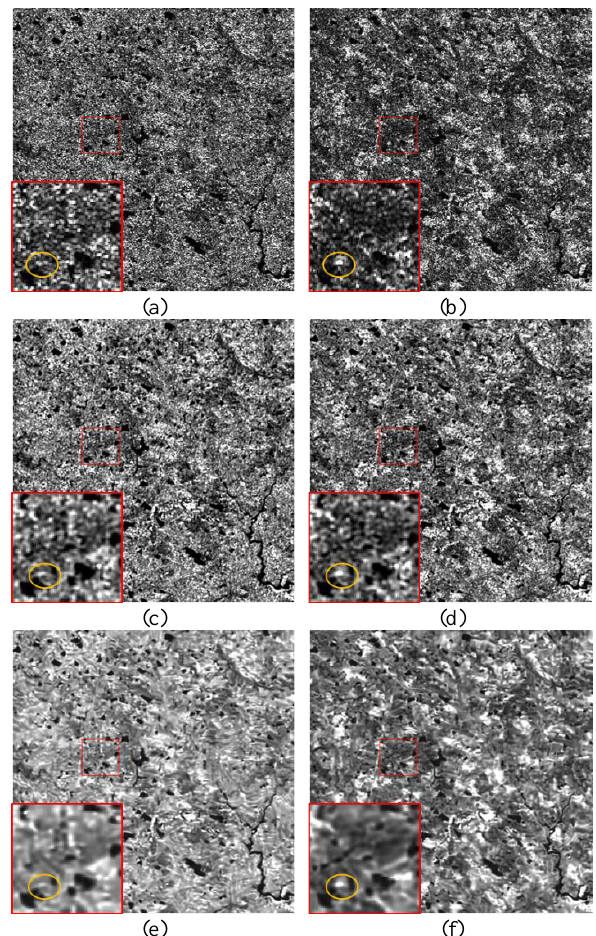
Fig. 7 The despeckling results of two different temporal Sentinel- 1 SLC images. (a) Noisy image of September 17, 2019. (b) Noisy image of October 11, 2019. (c) and (d) the proposed MSAR-CNN despeckling results of (a) and (b). (e) and (f) RABASAR despeckling results of (a) and